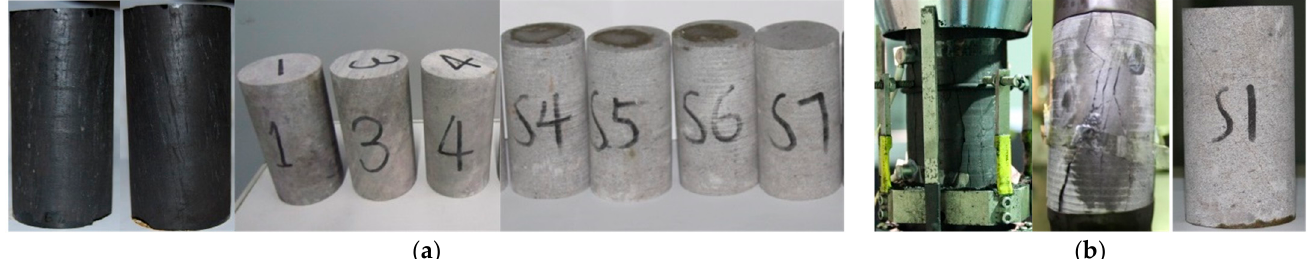
Figure 5. Rock specimens before and after uniaxial compression test. ( a ) Intact specimens; ( b ) failure modes.